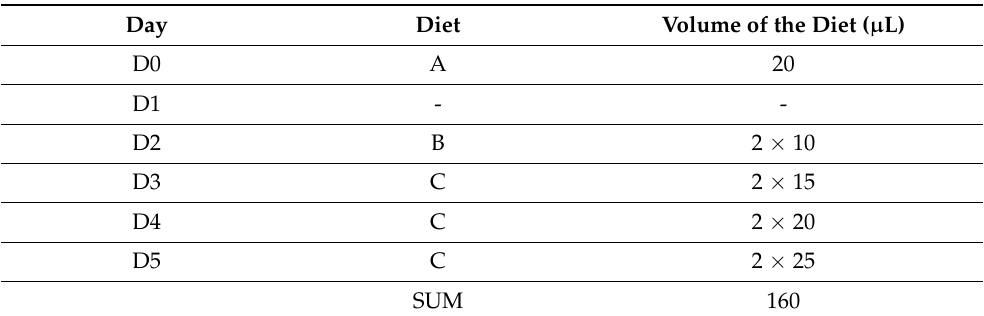
Table 2. Daily food volumes and the diet used (A, B, or C), supplied to the larvae depending on the age of the